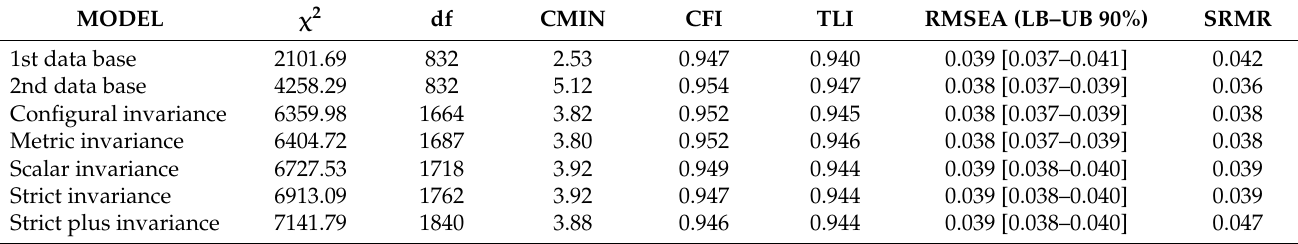
Table 1. Measurement invariance across the two